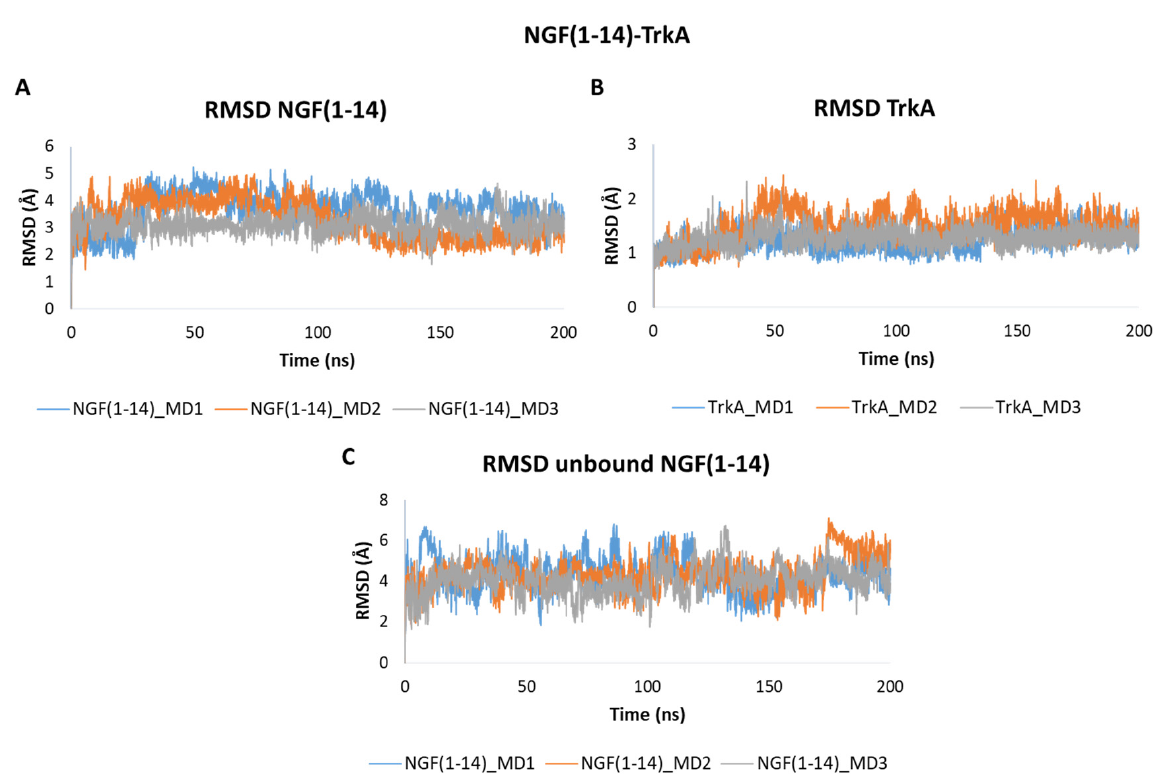
Figure 6. RMSD plots of the backbones of ( A ) NGF(1–14) and ( B ) TrkA registered during the three MD runs performed on NGF(1–14)-TrkA complex. ( C ) RMSD of NGF(1–14) backbone simulated in the unbound form.